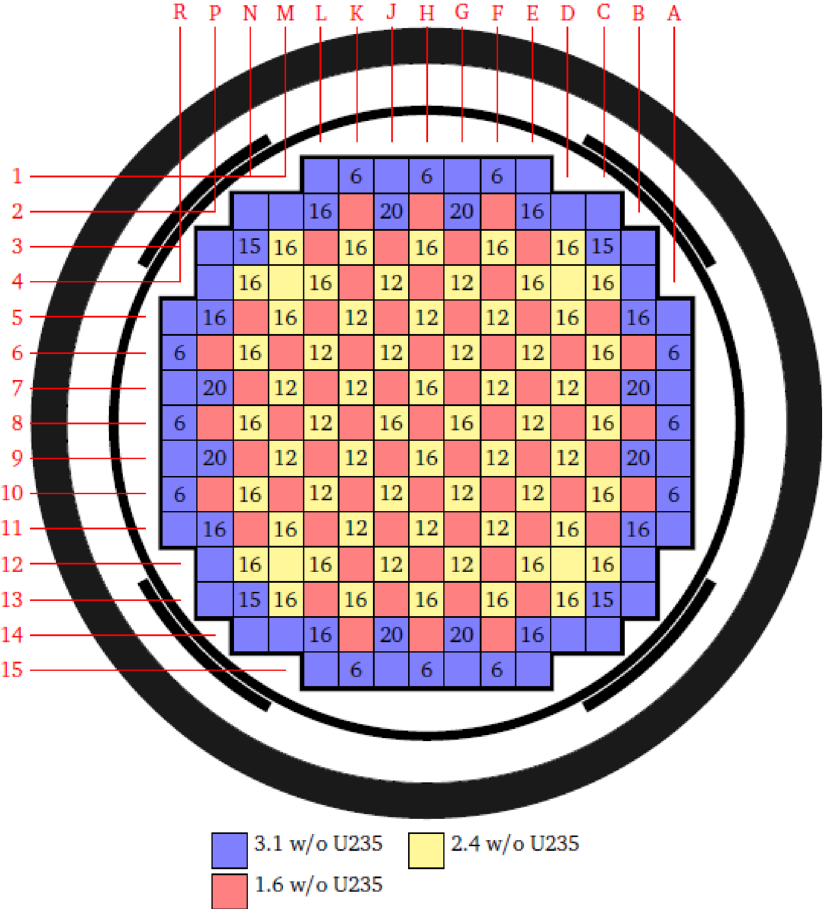
Fig. 1. Composition of BEAVRS core at cycle